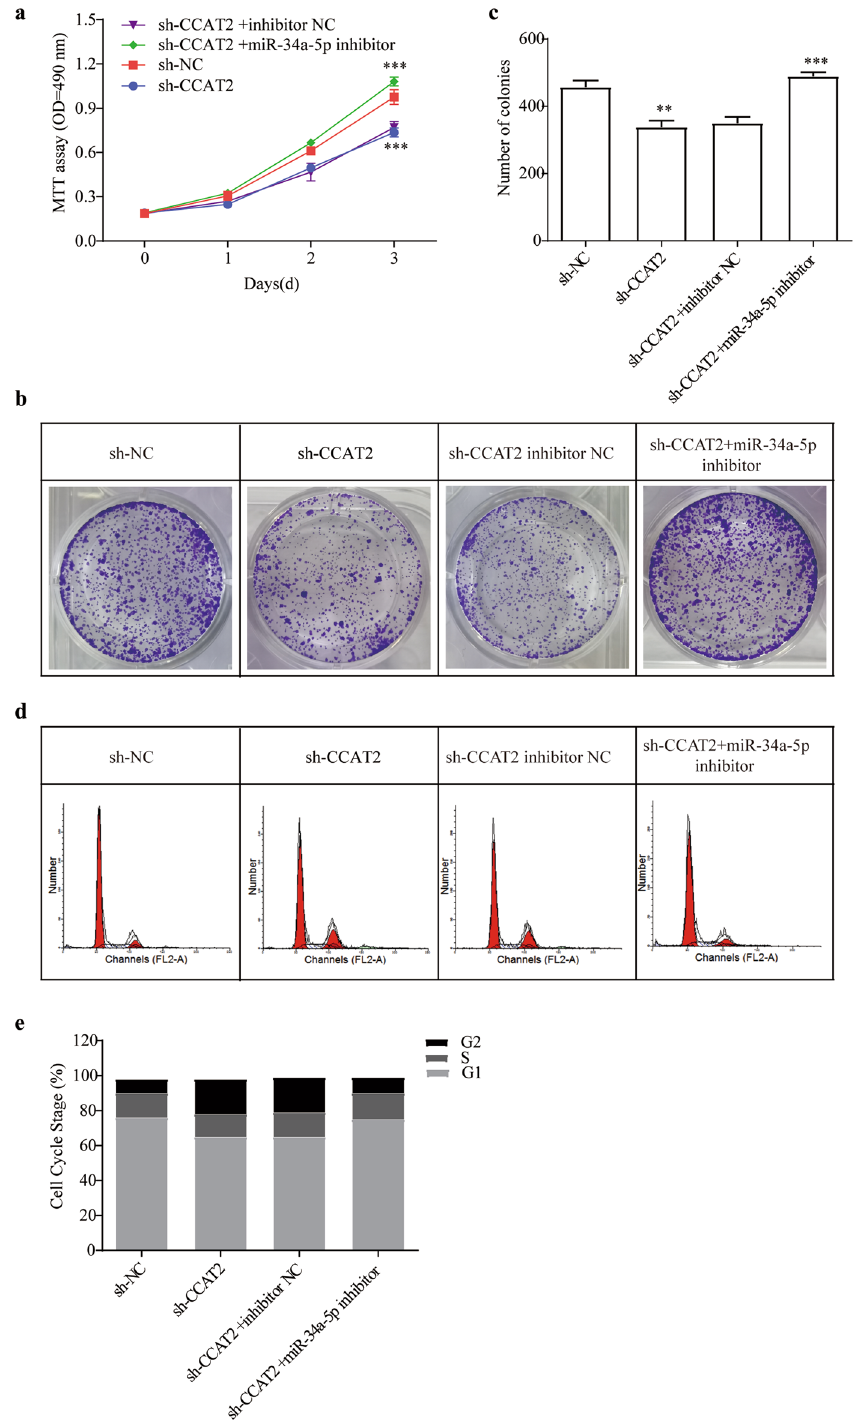
Figure 6. CCAT2 regulates lx-2 cells through miR-34a-5p. ( a ) Comparison of cell proliferation of HSCs co-transfected with sh-CCAT2 and miR-34a-5p mimic or inhibitor was determined by MTT assay. ( b ) Colony formation assay and ( c ) the quantification. ( d ) and ( e ) Cell-cycle distribution by flow cytometry, and statistical analysis of distribution of HSCs cell cycle